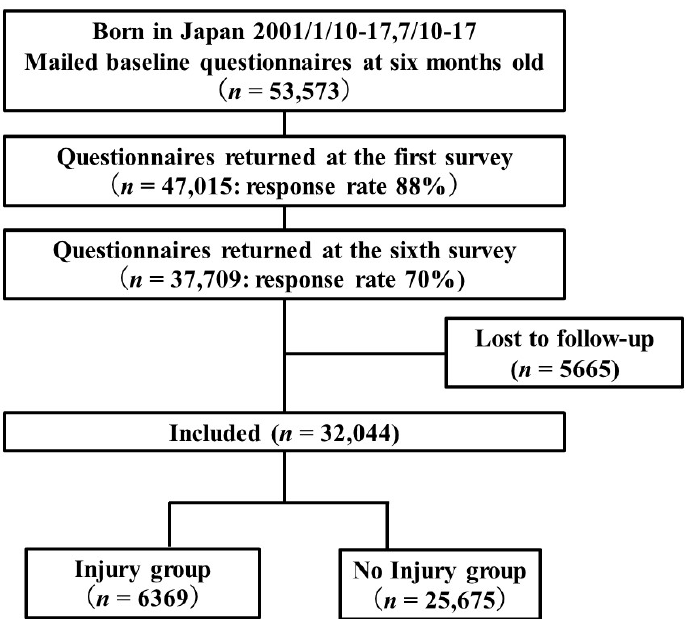
Figure 1. Flow diagram for the selection of participant children from birth to seven to nine years old.